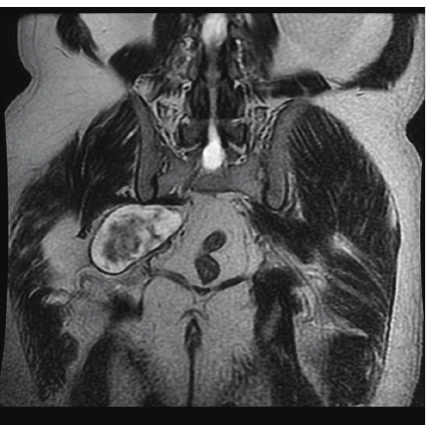
Figure 1: Coronal MRI of the lesion.